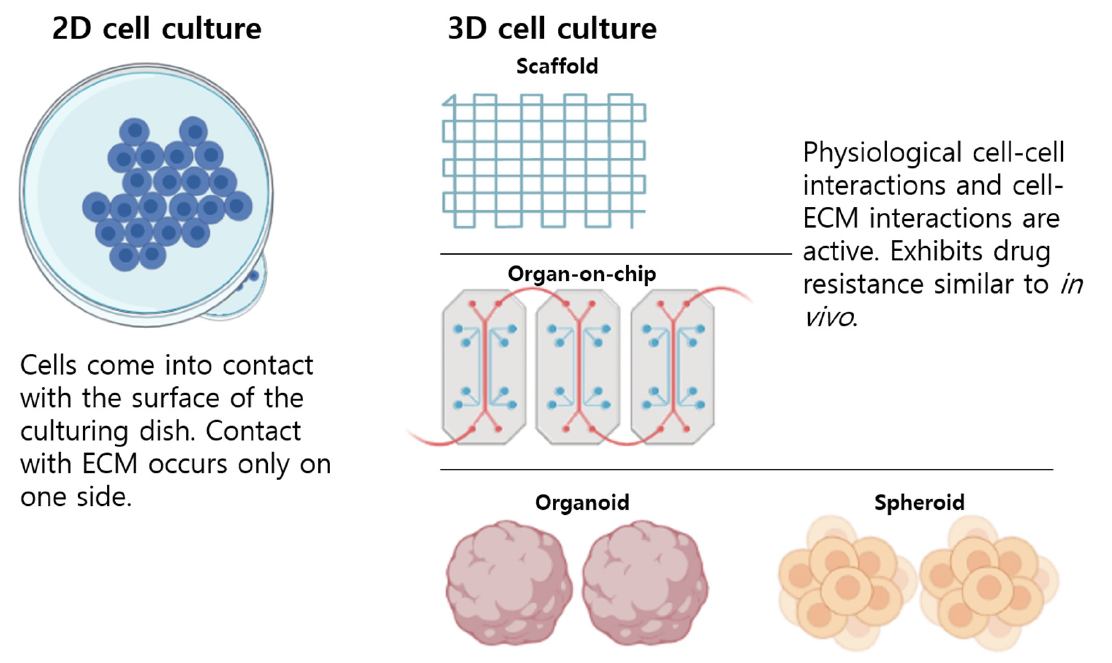
Figure 1. A basic comparison of two- and three-dimensional (2D and 3D) cell culture systems. Improved forms of in vitro cell culture models are similar to in vivo conditions. Three-dimensional cell cultures mimic the tissue physiology of multicellular organisms.